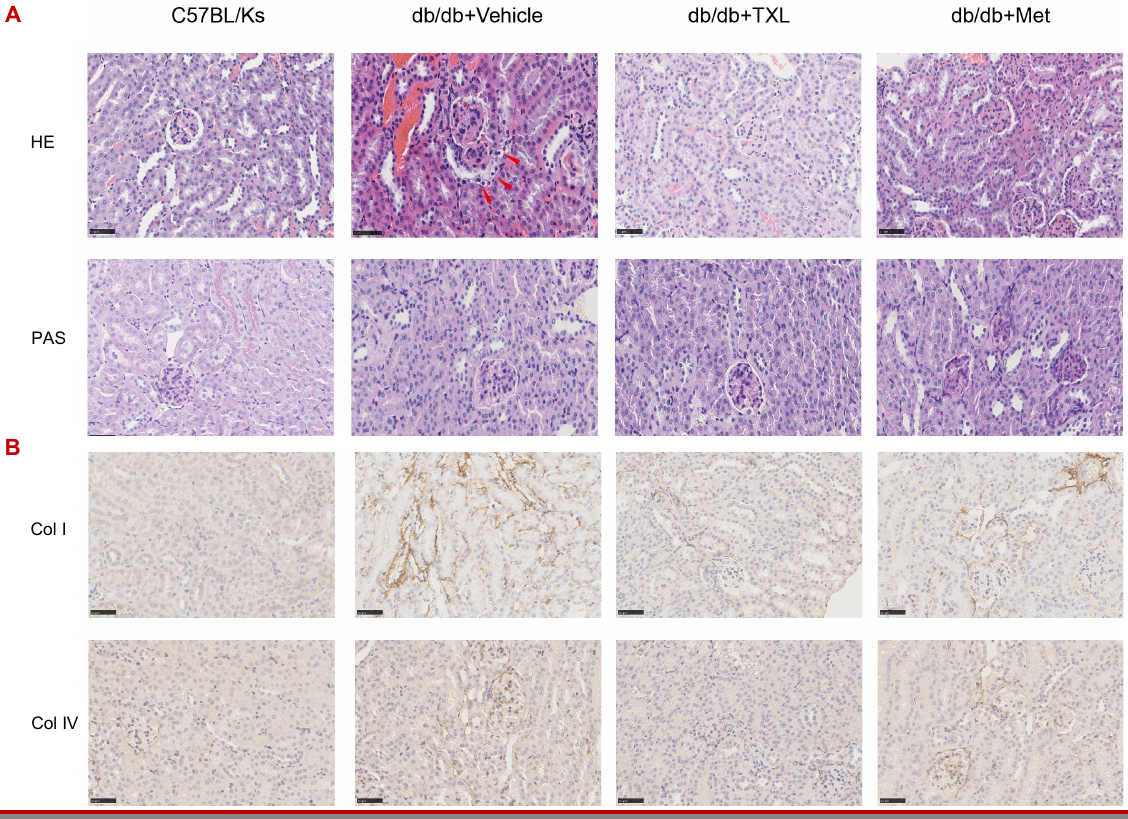
Figure 2: Tongxinluo (TXL) improves renal morphologic abnormalities and reduces interstitial collagen deposition in the kidney of db/db mice. HE and PAS staining of kidney tissue from the investigated mice (×400) (A). Scale bar, 50 μ m; Relative col I and col IV expression levels in renal cortex from mice measured by immunohistochemical staining (×400). Scale bar, 50 μ m